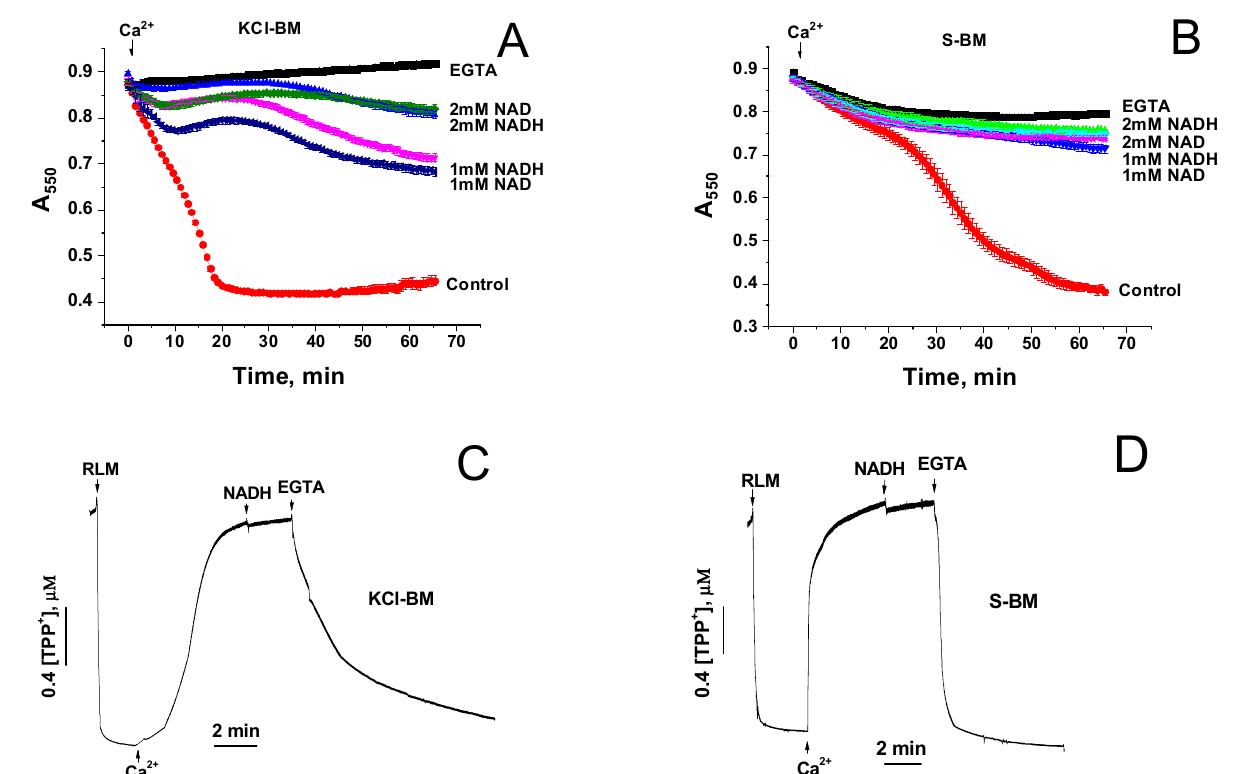
Figure 4. Effect of NADH and NAD + on the Ca 2+ -induced mitochondrial swelling in KCl-BM ( A ) and S-BM ( B ). Prior to the measurements, RLM (0.75 mg prot./mL) were added to KCl-BM or S-BM supplemented, where indicated, with 1 mM EGTA and 1–2 mM NADH and NAD + . Arrows show the addition of 100 µ M Ca 2+ . ( C , D ). Effect of NADH and EGTA on the recovery of ∆Ψ m in KCl-BM and S-BM. Just before measurements, 1.5 µ M TPP + was added to KCl-BM ( C ) or S-BM ( D ). Arrows show the addition of RLM (1 mg prot./mL), 100 ( C ) and 400 µ M Ca 2+ ( D ), 1 mM NADH, and 1 mM EGTA. Representative curves of one experiment of at least three similar are shown.